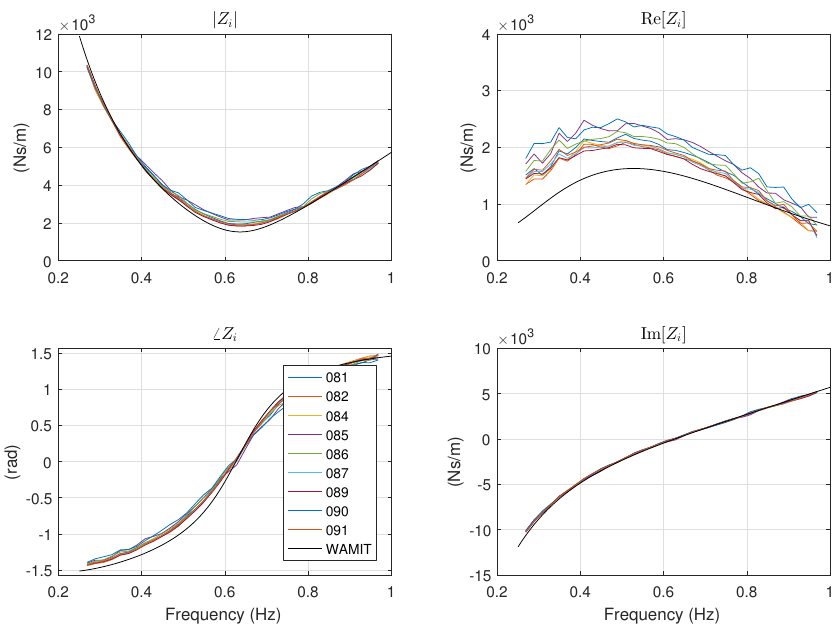
Figure 13. Intrinsic impedance estimated from all the experiments. Frequency smoothing has been performed over a window of 12